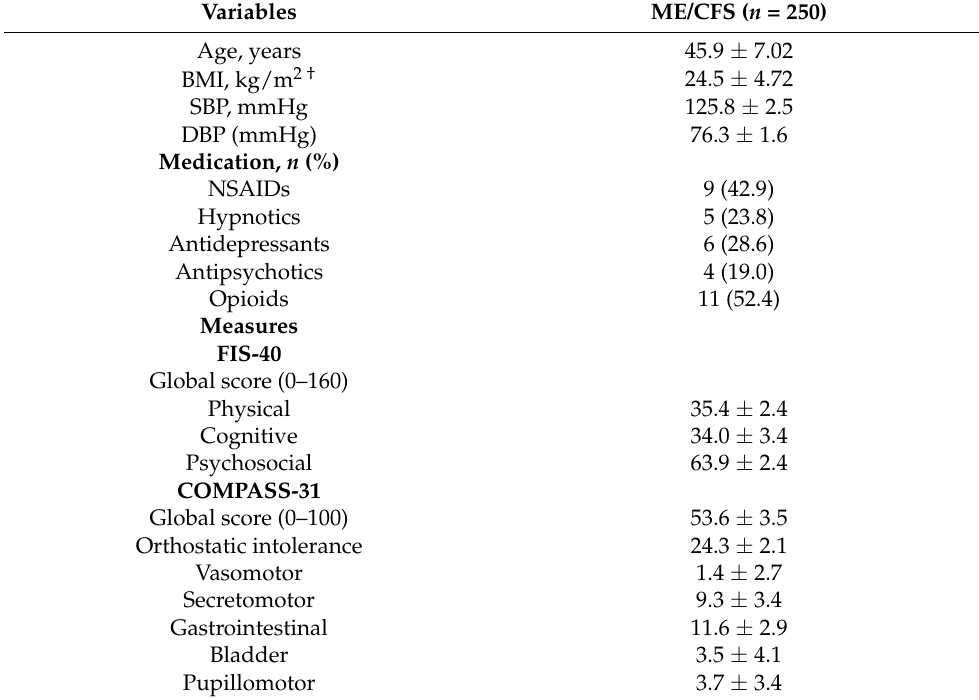
Table 1. Demographics and clinical characteristics of participants at baseline. Data are expressed as the mean ± standard deviation (SD) for continuous variables and compared by Student t -test, whereas categorical variables are given as numbers with percentages (%) and compared by Fisher’s exact